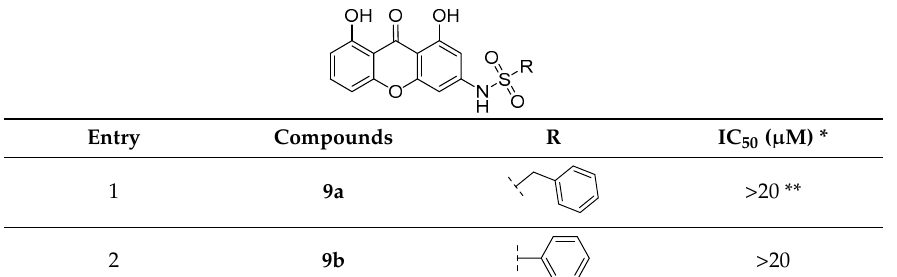
Table 1. Inhibitory activities of 9a – 9n against PGAM1.